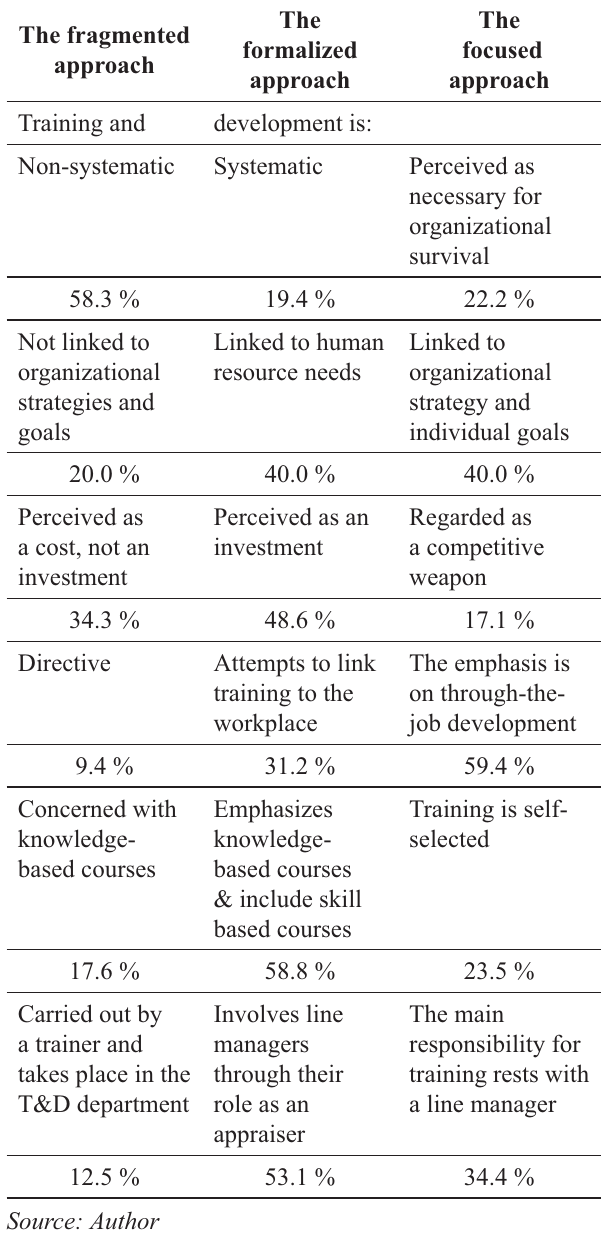
Table 3. Results of Learning Approach in Organizations